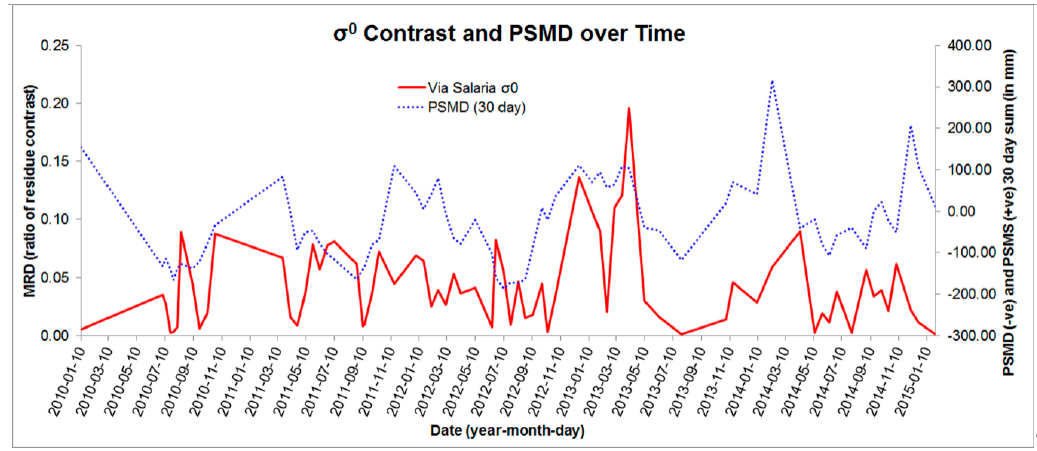
Figure 51. Graph showing clarity (contrast) of the residue of the ancient Via Salaria (in red), plotted over time and with PSMD (blue dotted line). The clarity of residues is quantified as a ratio (MRD). For the PSMD, negative values correspond to high PSMD (dry conditions), while positive values correspond to high PSMS (wet conditions).